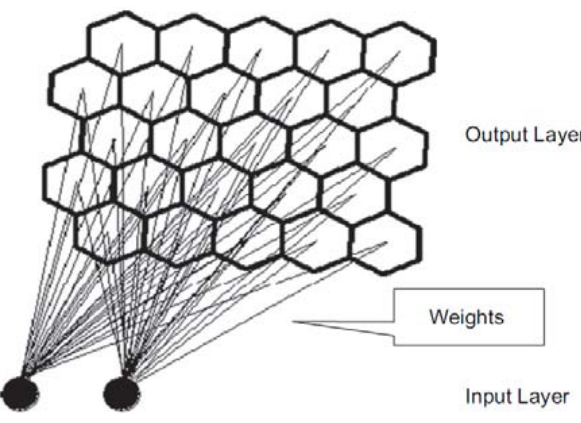
Fig. 1. Structure of a 5 × 5 two-dimensional self organizing map (SOM) (after Kalteh et al.,